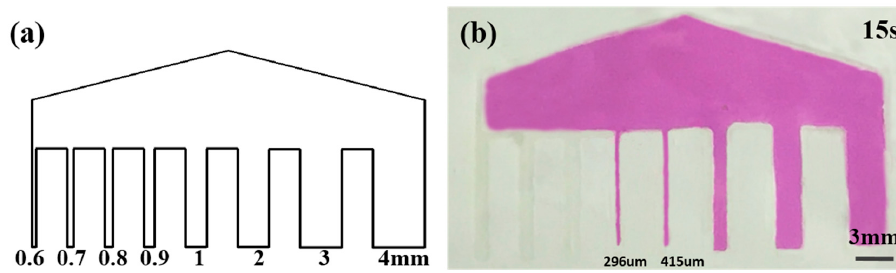
Figure 8. ( a ) Resolution test pattern. ( b ) Resolution of the hydrophilic channels after heating for 15 s.